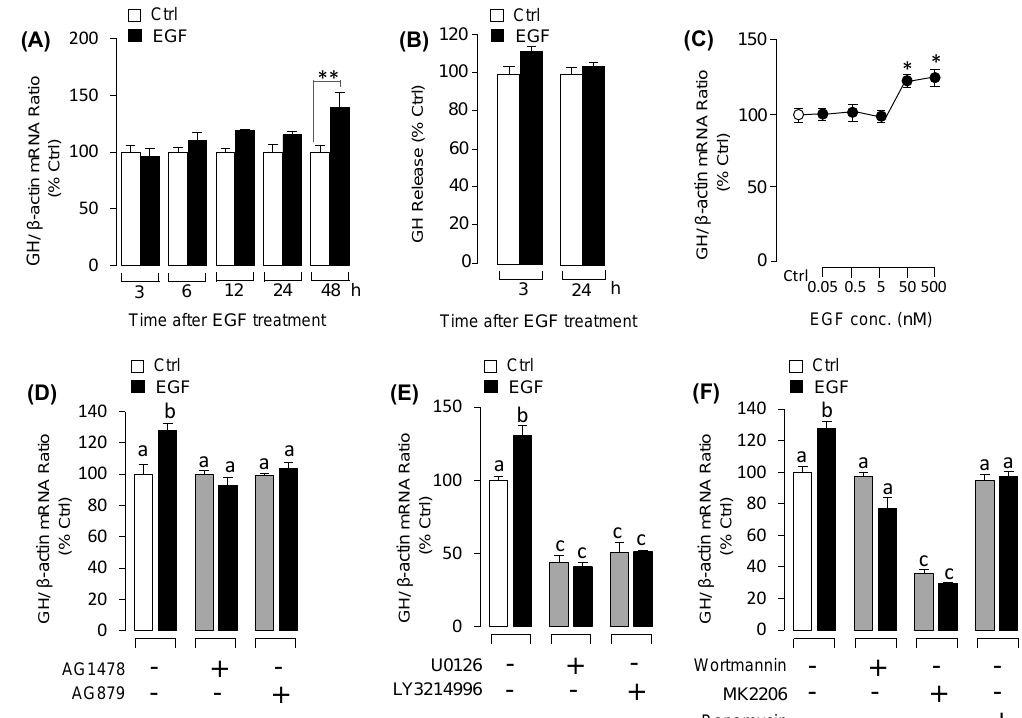
Figure 3. The e ff ects of EGF on growth hormone (GH) secretion and mRNA expression in grass Figure 3. The effects of EGF on growth hormone (GH) secretion and mRNA expression in grass carp Fig. 3. The effects of EGF on GH secretion and mRNA expression in grass carp pituitary cells: Receptor carp pituitary cells: receptor specificity and signal pathways. ( A ) Time course of EGF (50 nM) on GH mRNA expression. ( B ) Time course of EGF (50nM) on GH release in grass carp pituitary cells. ( C ) Dose-dependence of 48-h incubation with increasing levels of EGF (0.05–500 nM) on GH